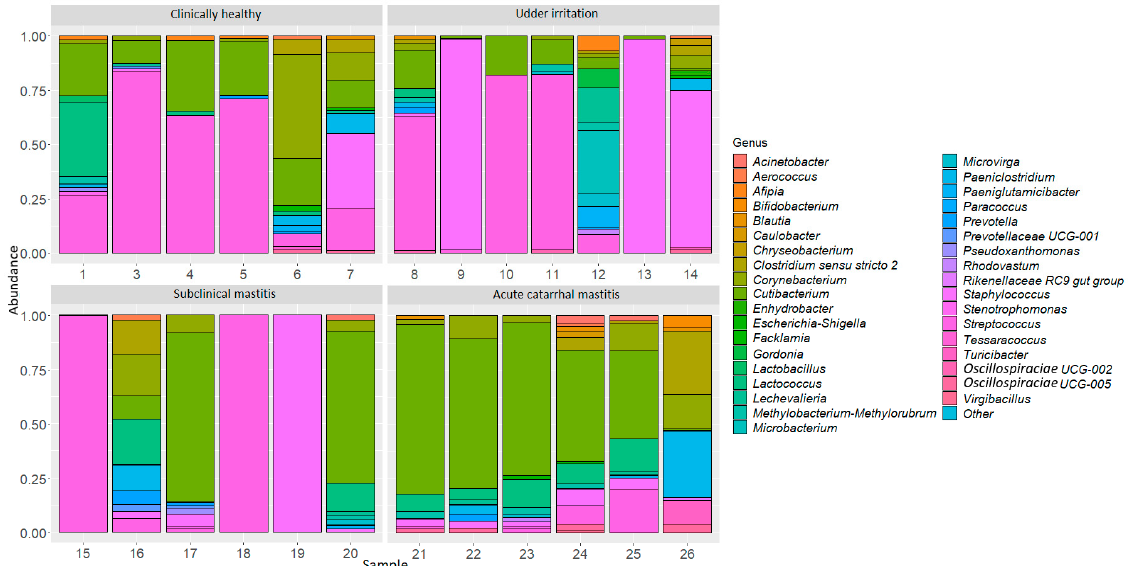
Figure 1. Taxonomic profile of the 37 most common bacterial genera in cow milk samples. We have observed that, in the group of cows with acute catarrhal mastitis, the number of genera increased for Cutibacterium of 2.43 times ( p = 0.0065), Blautia of 3.46 times ( p = 0.0076), Colidextribacter of 3.91 times ( p = 0.0047), Clostridium sensu structo 2 of 5.66 times ( p = 0.0038), Paeniclostridium of 5.76 times ( p = 0.0056), Bifidobacterium of 8.35 times ( p = 0.0005), and Turicibacter of 8.48 times ( p = 0.0079), compared to the healthy control group (Figure 2).